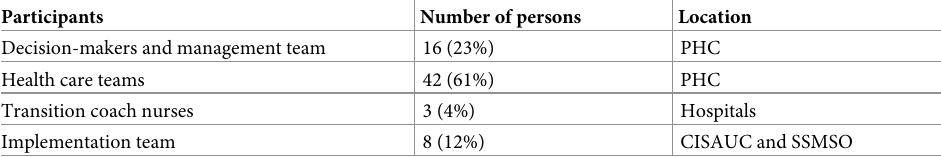
Table 1. Description of the